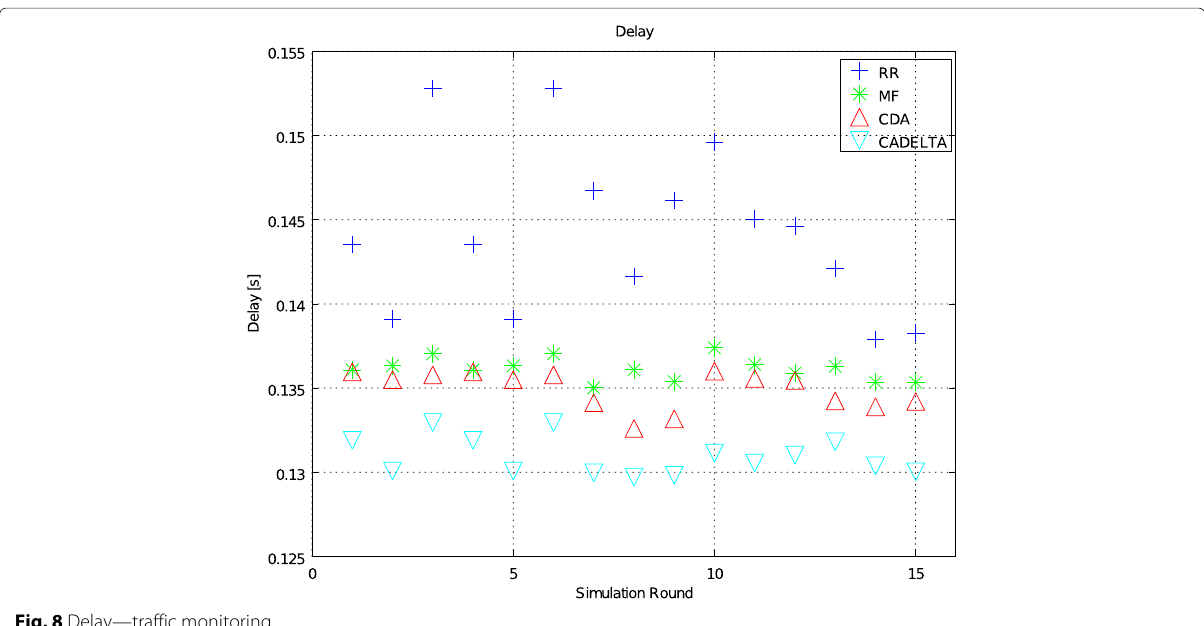
hand, both our solutions are more robust to the traffic change and perform well, with an increment of through- put with respect to RR in the order of 70–80%. Comparing Figs. 6 and 9, it is possible to observe that in the for- mer, CDA results on average in a lower fairness than channel- and delay-aware (CADELTA), while in the latter is exactly the opposite. This suggested that CDA is less sensible to the traffic changes; in fact, in all the results